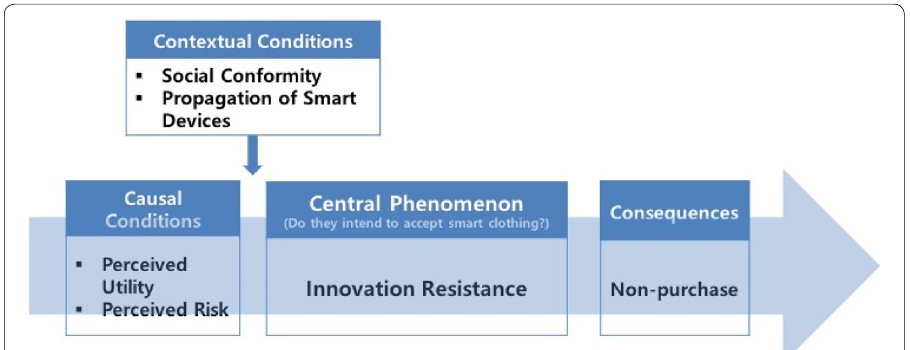
Fig. 1 A paradigm of smart clothing resistance and